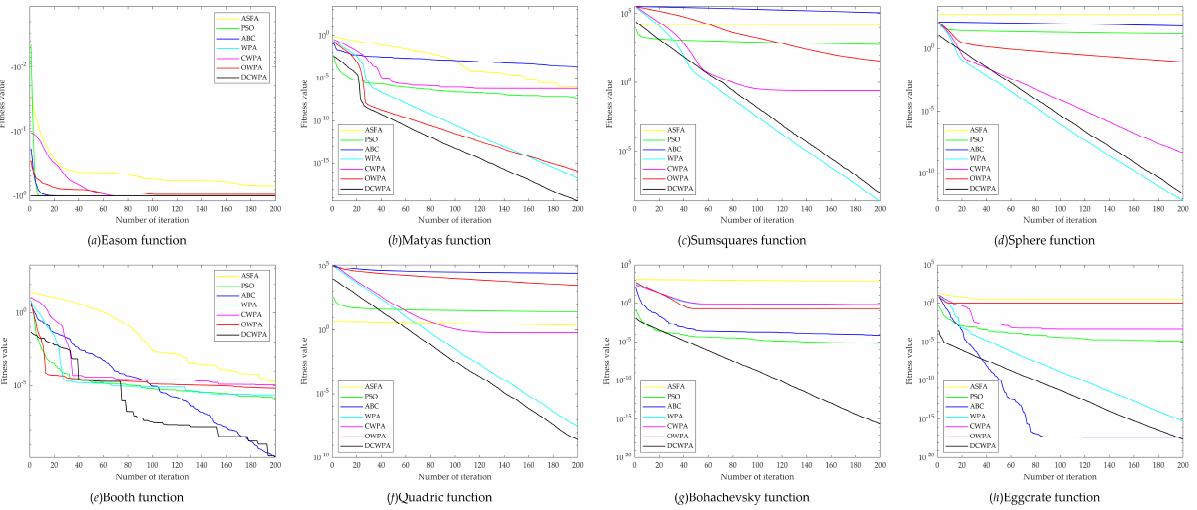
Figure 12. Comparison of the average convergence curves of the eight functions.